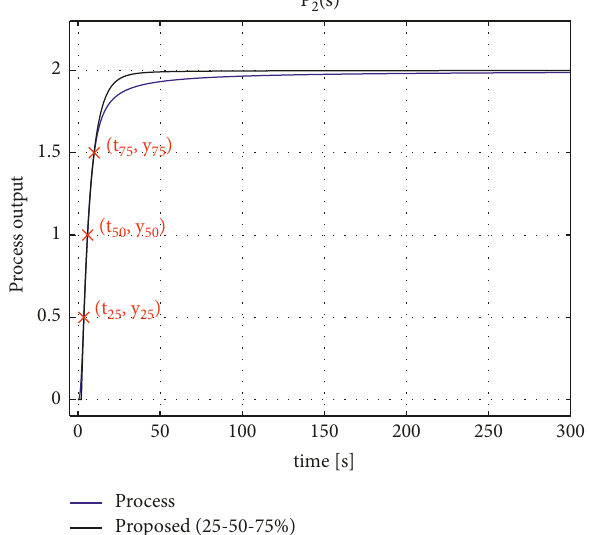
Figure 20: Process reaction curve and FFOPDT model method # 5 (25–50–75%) step response for process P 2 .